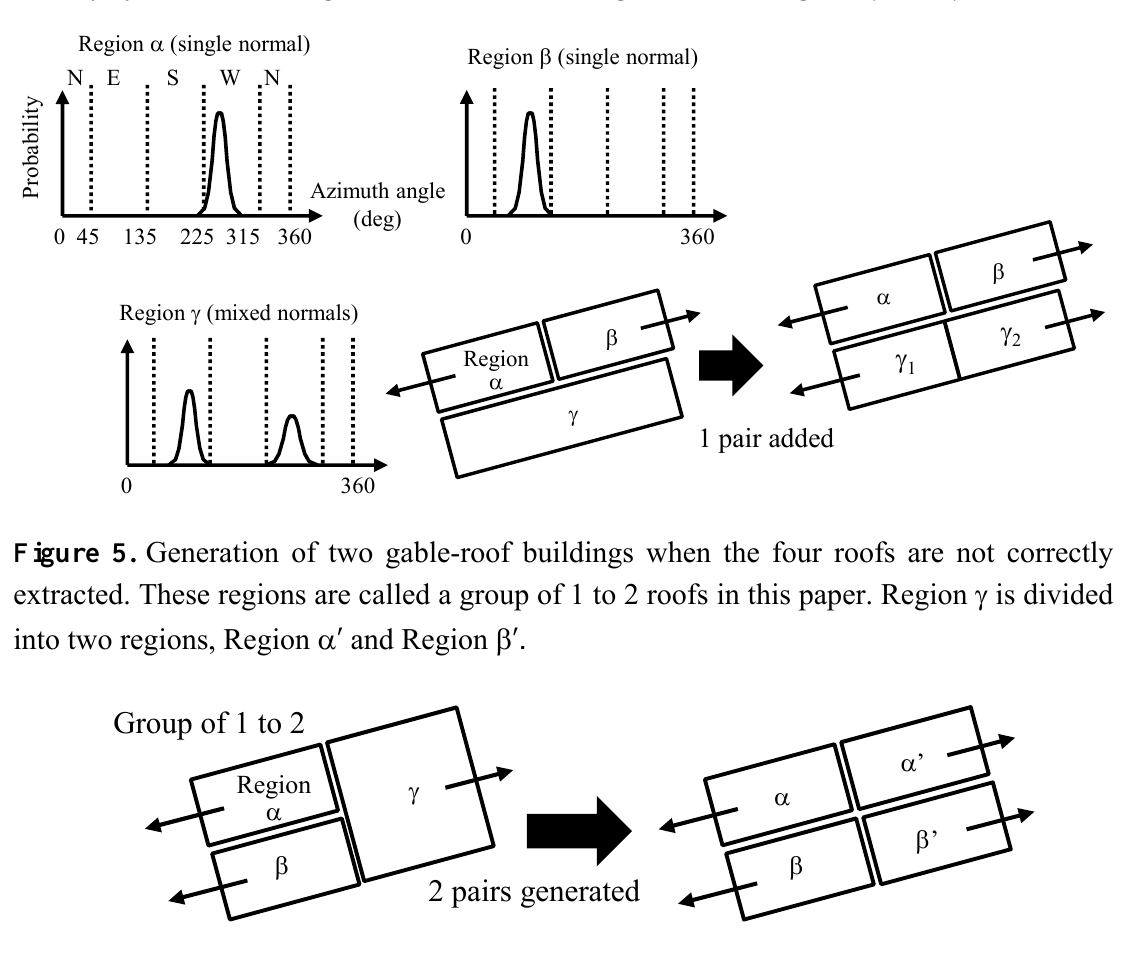
Figure 4. Determination of principal azimuth of a region. “N”, “E”, “S”, and “W” denote north, east, south, and west, respectively. As the two dominant normals of Region  are linearly symmetric, the region is divided into two gable roofs, Regions 